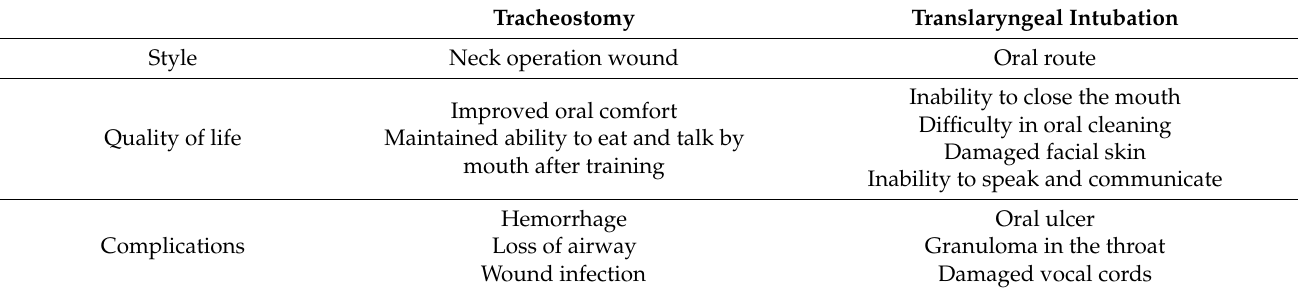
Table 1. Comparison of patient characteristics between tracheostomy and translaryngeal intubation. Tracheostomy Translaryngeal